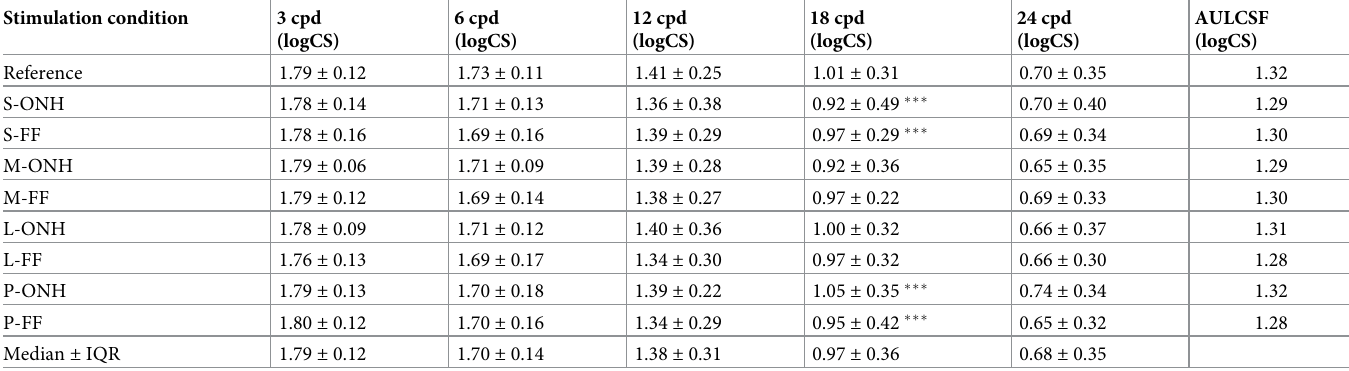
Table 2. Contrast sensitivity (CS), in logCS, measured before any stimulation as reference and after each stimulation condition including short- (S), middle- (M), long-wavelength light (L) and polychromatic light (P) stimulating the eye screen full-field (FF) or only the optic nerve head (ONH). Median, interquartile range (IQR) and area under the logarithmic contrast sensitivity function (AULCSF) are listed to compare each condition (n = 30; ��� p < 0.0001). Stimulation condition 3 cpd 6 cpd 12 cpd (logCS) (logCS)